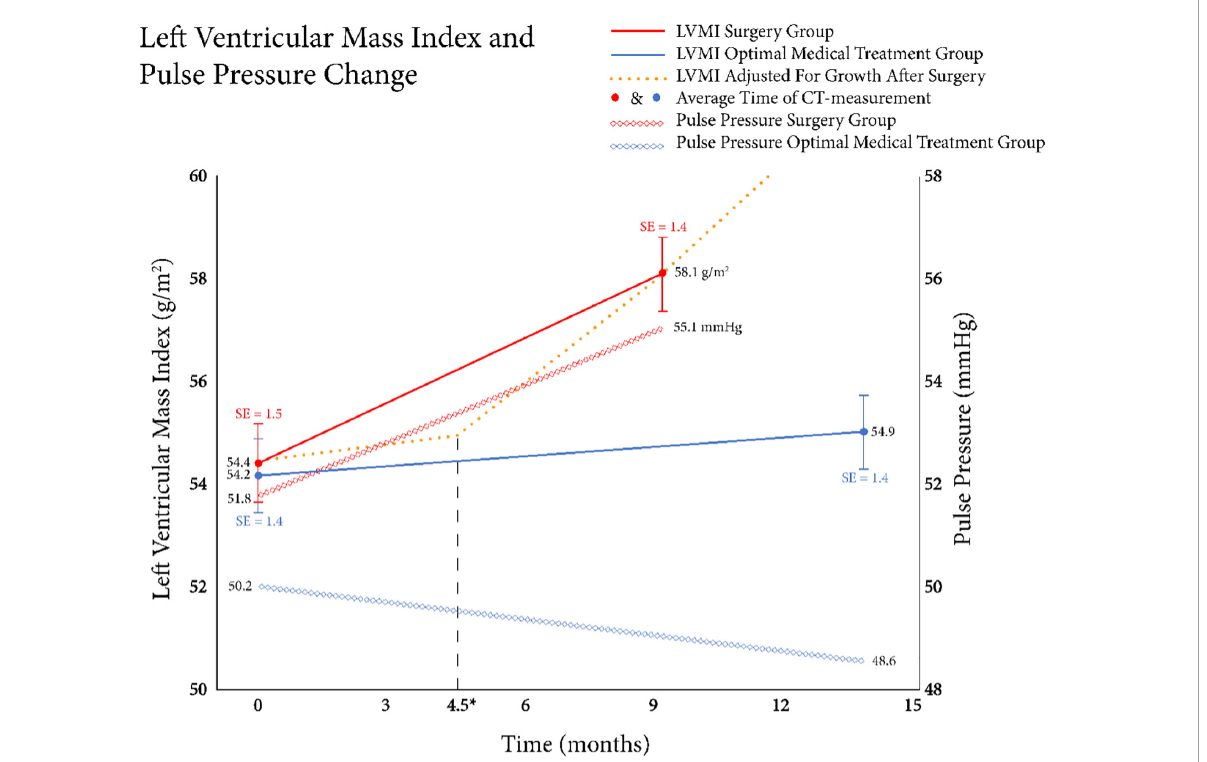
FIGURE3 Relationship between left ventricular mass index (LVMI) change and pulse pressure change. The mean LVMI was shown in the left y-axis and the solid lines show the mean LVMI at the two measured time points for both the surgery + optimal medical treatment (OMT) group (red) and the OMT group (blue). The x-axis depicts the follow-up time in months. A significant difference in LVMI increase between groups was seen, respectively: 3.7 vs. 0.6 g/m 2 ( p = 0.001; Student’s t -test). Black dashed vertical line depicts the average time of the surgery after the baseline CT. Additionally, the average pulse pressure changes over time between groups were shown as the diamond shaped lines. The right y-axis depicts the pulse pressures in millimeters of mercury. Although an increase in pulse pressure was found in the surgery + OMT group (3.3 mmHg), where a decrease was found in the OMT group ( − 1.6 mmHg), the difference between groups was not significant ( p =